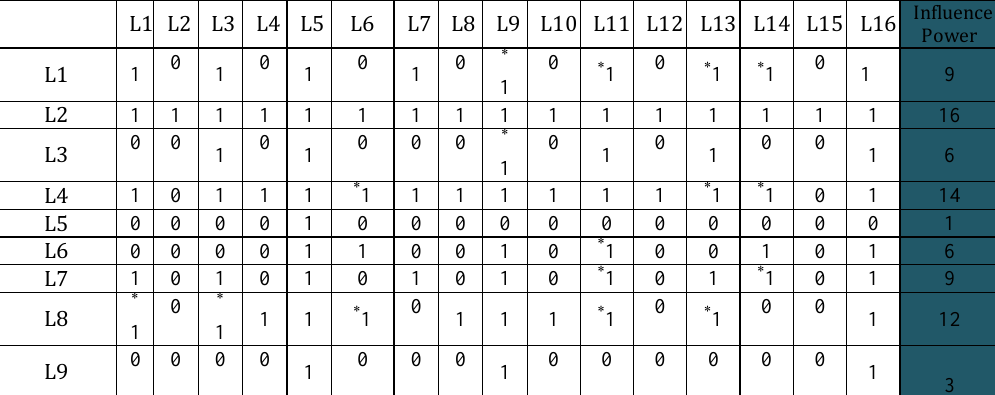
Table 10. Reachability matrix in terms of the transitivity of the relationship between the